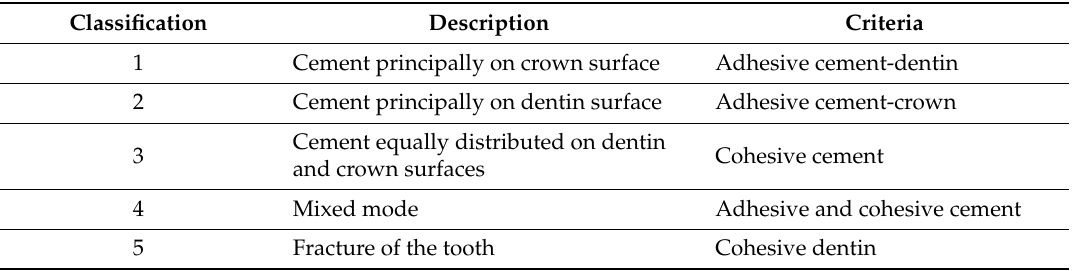
Table 2. Classification of failure